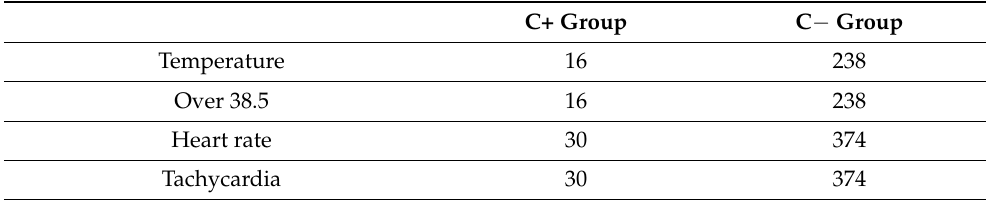
Table A3. Description of missing data by variable in Table